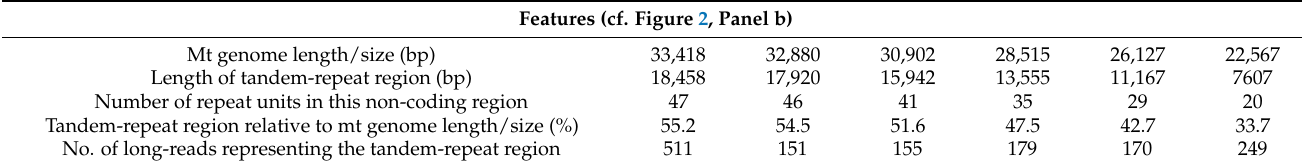
Figure 1. Distribution of repeat unit frequencies and long-read lengths. Both panels represent Nanopore long-reads ( n = 1760) that spanned the entirety of the tandem-repeat region. Table 1. Features of the six representative mitochondrial (mt) genomes defined for Schistosoma haematobium and their respective tandem-repetitive, non-coding